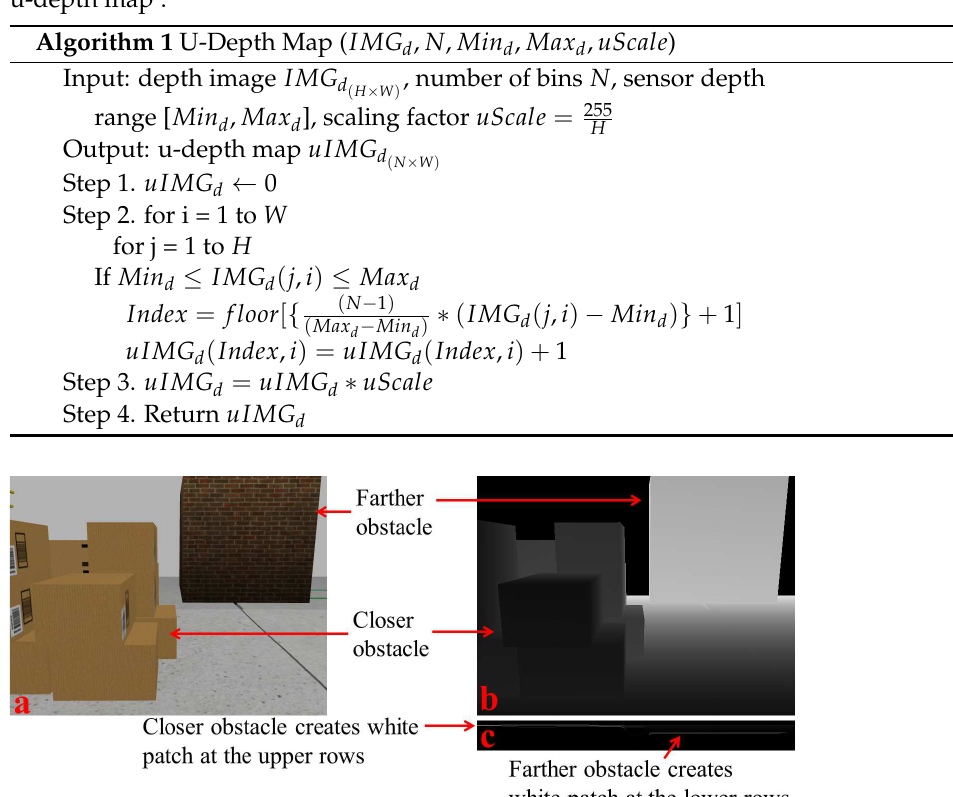
Algorithm 1 U-Depth Map ( IMG d , N , Min d , Max d , uScale )